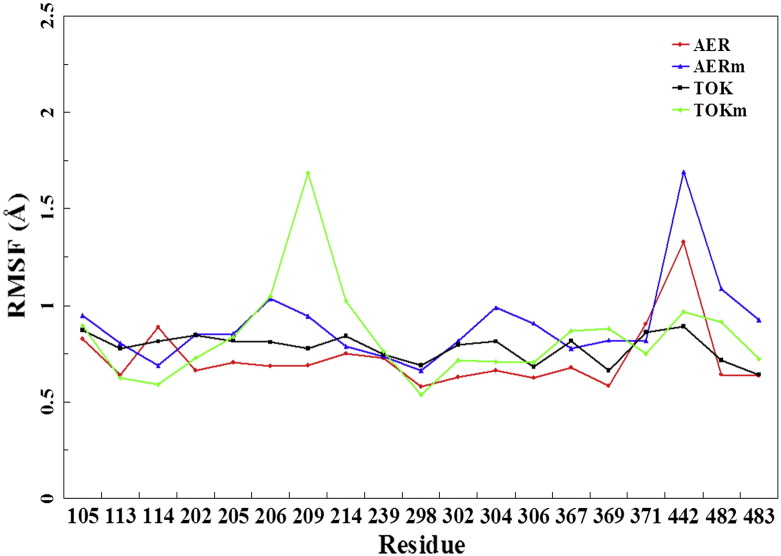
The calculated RMSF variations of Cα atoms of active site residues of AER (red line), AERm (blue line), TOK (black line), and TOKm (green line).